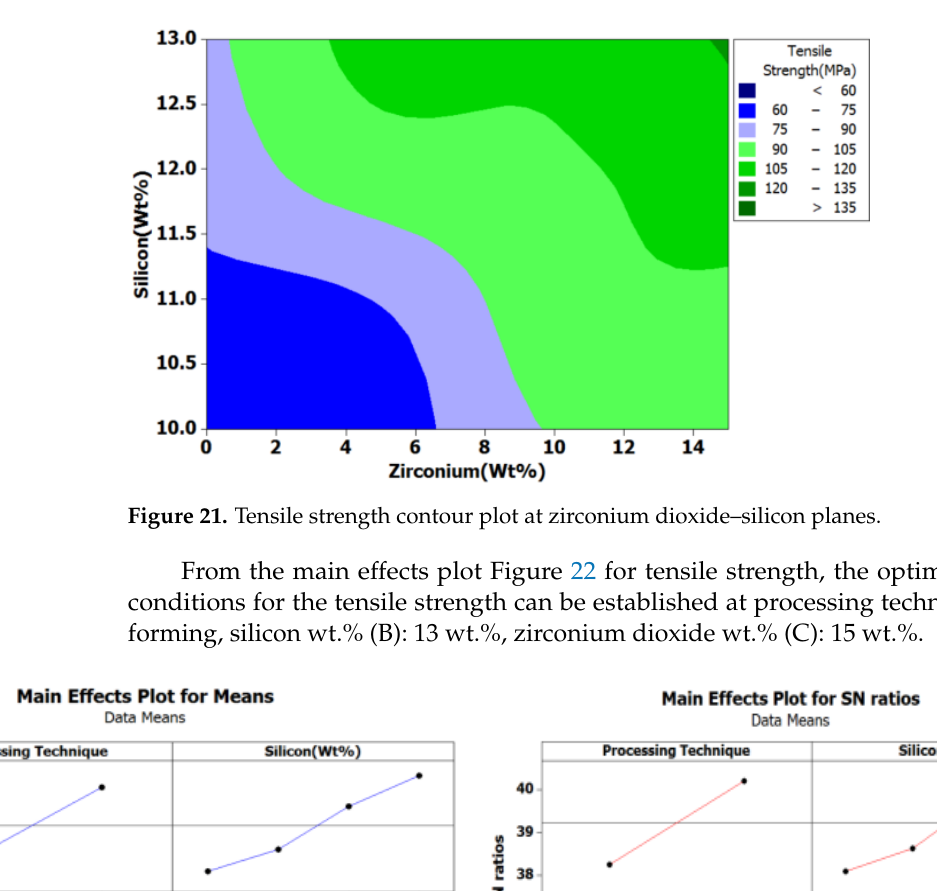
104.25 Figure 23. Tensilestrength test specimens of spray forming processing techniques of Si-Al alloy matrix reinforced with ( a ) 0% ( b ) 5% ( c ) 10% ( d ) 15% ZrO 2 particulates for 13 wt.% Si.